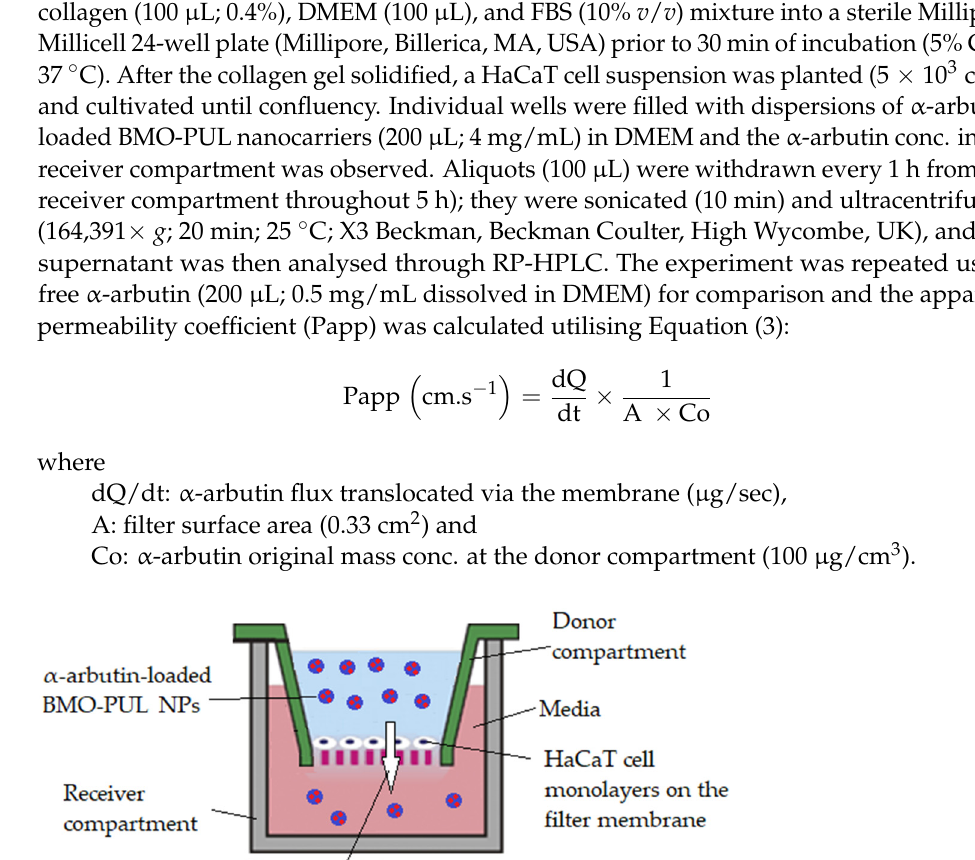
OH Figure 2. A schematic of the synthesis of grafted pullulan (BMO-PUL). The lyophilised products were acquired as low-density, white cotton-like materials (yield 81–84%), with the chemical modification being verified by 1 H- and 13 C-NMR, as well as FTIR spectroscopy. The Mw was in the range 100–136 kDa, as analysed by gel permea- tion chromatography (GPC). In the 1 H-NMR spectra of BMO-PUL (Figure 3a), the peaks of pullulan backbone protons appeared over the spectral range δ 3.3–5.4 ppm; 3.3–4 ppm assigned to proton signals at C 2 − 6 , whilst 5–5.4 ppm was assigned to anomeric protons [11]. The signals recorded at δ 0.9, δ 1.3, and δ 1.5 ppm (denoted as peaks 3, 2, and 1 in Figure 3, respectively) were indicative of the existence of the hydrophobic alkyl chain groups [38]; other protons signal assignments are presented in Figure 3a. The 13 C-NMR spectrum concurred with the 1 H-NMR data, with alkyl chain carbons detected at δ = 14, 19, 31, 44, 51, and 71 ppm, as displayed in Figure 3b. The 13 C-NMR spectrum of the BMO reagent is recorded in Figure S1, Supplementary Materials. Other significant peaks in the 13 C-NMR